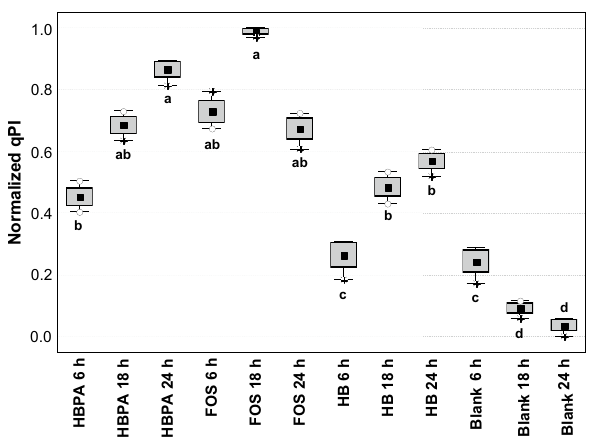
Figure 1. qPCR Prebiotic Index (qPI) of colonic fermentations on the substrates HBPA, HB, FOS, and on a blank control, at different time points. abcd Different letters indicate statistical significance by Tukey’s honestly significant differences (HSD) test ( p < 0.05). Marker = mean; box = mean ± S.D.; whiskers = min and max; dots = outliers; asterisks = extremes. HB Hempseed bran; HBPA HB protein extract hydrolyzed by alcalase; FOS fructooligosaccharides; Blank Blank